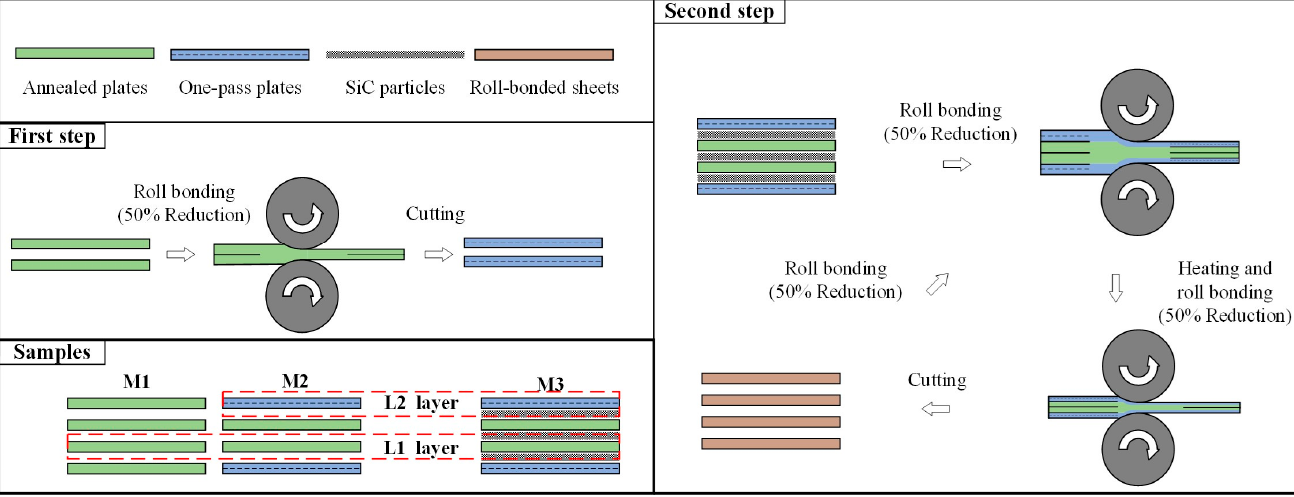
Figure 2. Schematic illustration of producing M1, M2 and M3 samples by the MARB process and illustration of L1 and L2 layers. illustration of L1 and L2